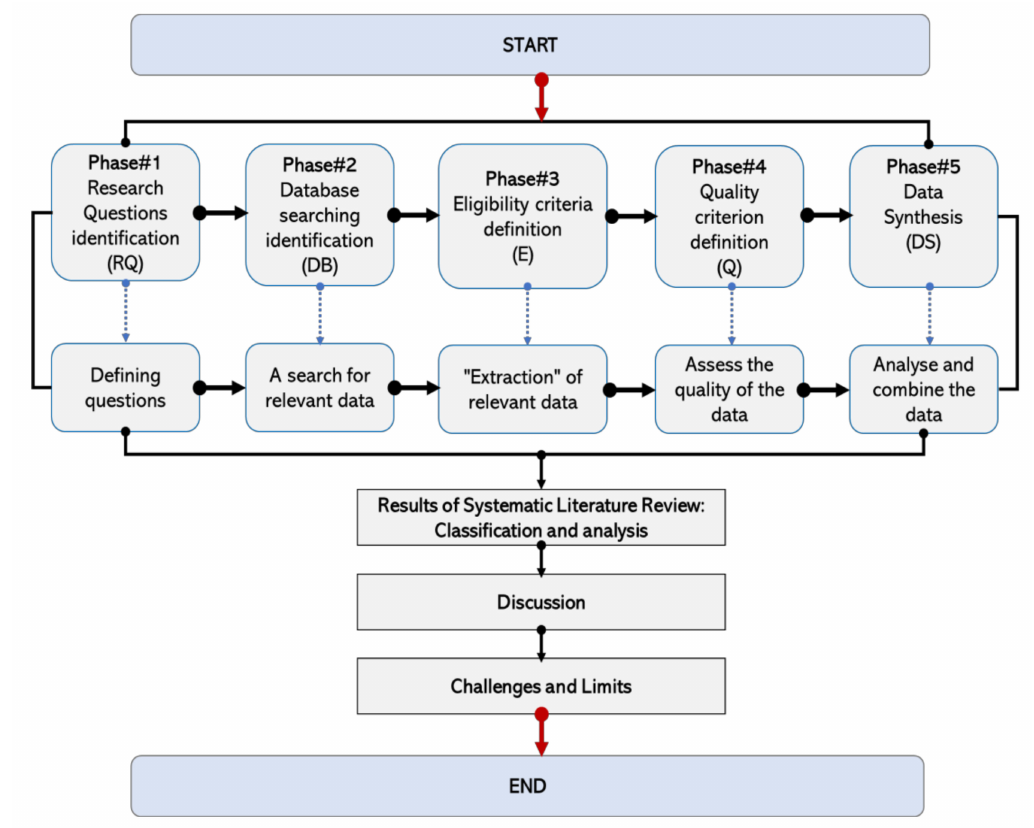
Figure 1. The main phases of the systematic literature review protocol (author’s